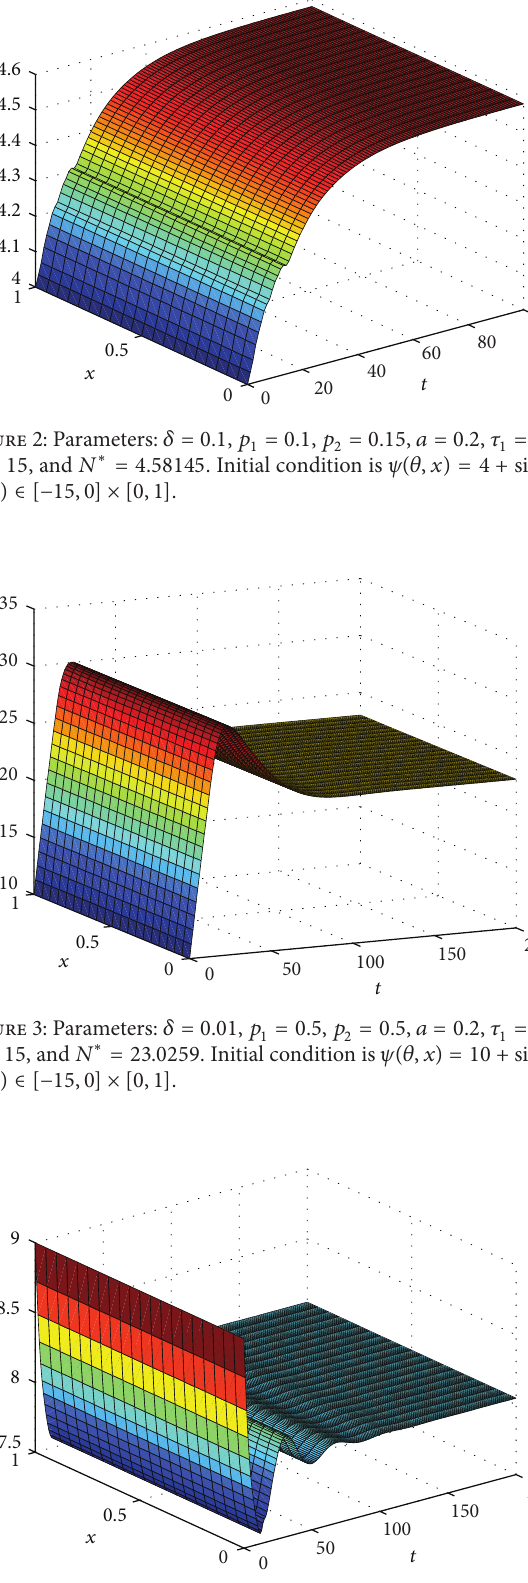
Figure 4: Parameters: 𝛿 = 0.2 , 𝑝 1 = 0.5 , 𝑝 2 = 0.5 , 𝑎 = 0.2 , 𝜏 1 = 12 , = 15 , and 𝑁 ∗ = 8.04719 . Initial condition is 𝜓(𝜃,𝑥) = 9 + sin 𝜃 , 𝜏 2 (𝜃, 𝑥) ∈ [−15,0] × [0,1]